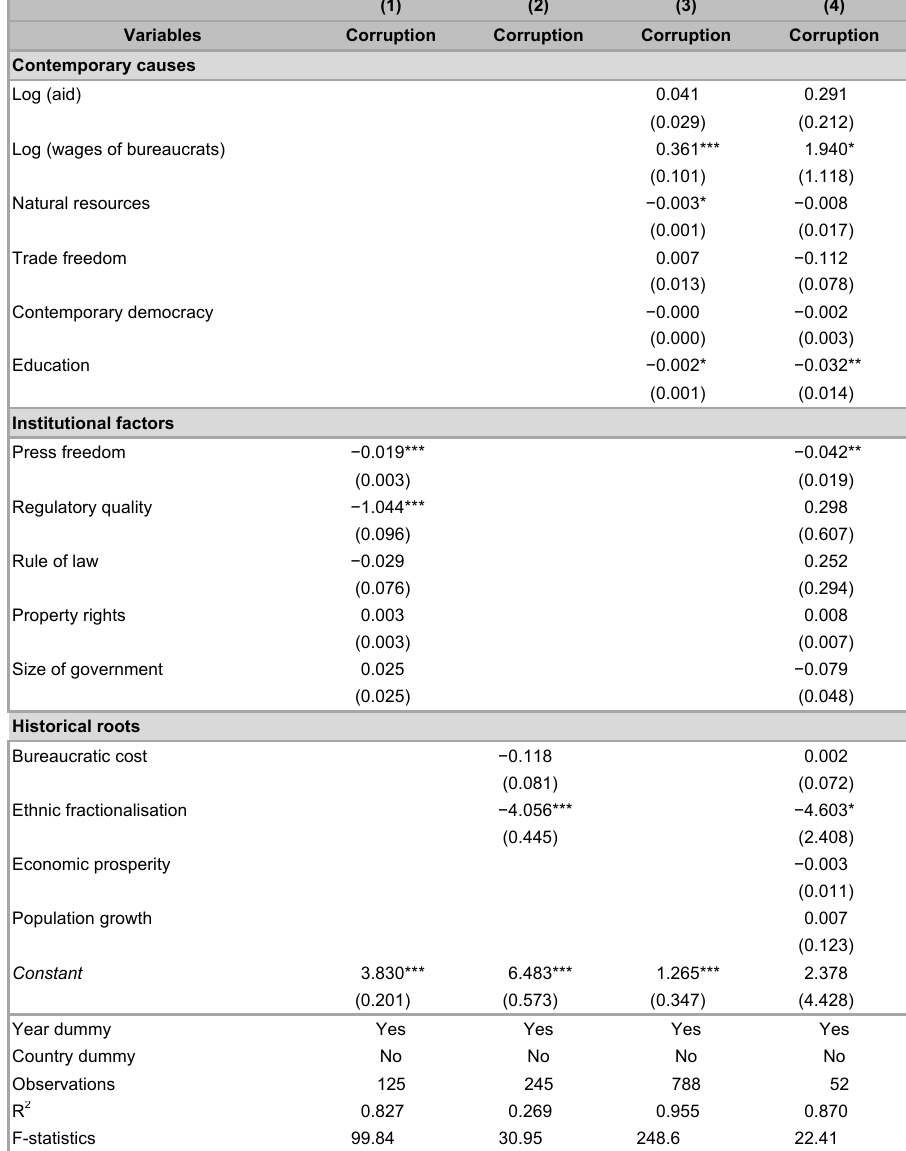
Corruption and its sources in sub-Saharan Africa: POLS